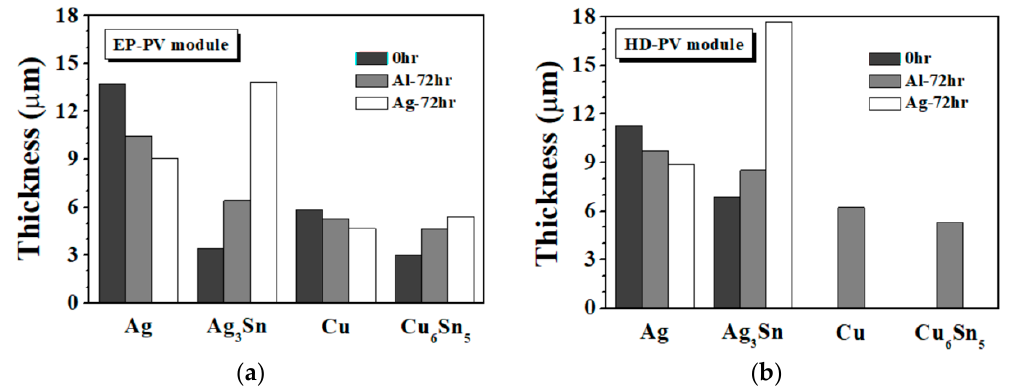
Figure 7. Interfacial microstructures of the HD PV module after Al-direction biasing for ( a ) 24 h and ( b ) 48 h.